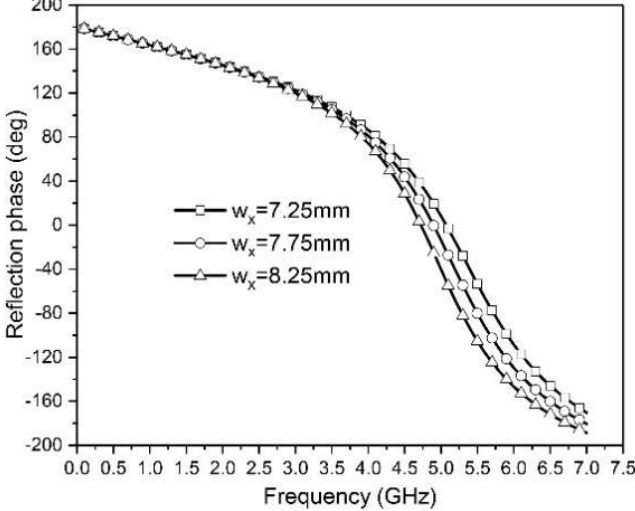
Figure 12. In-phase diagram of mushroom unit cell with different top metal patch sizes 𝑊 𝑥 .